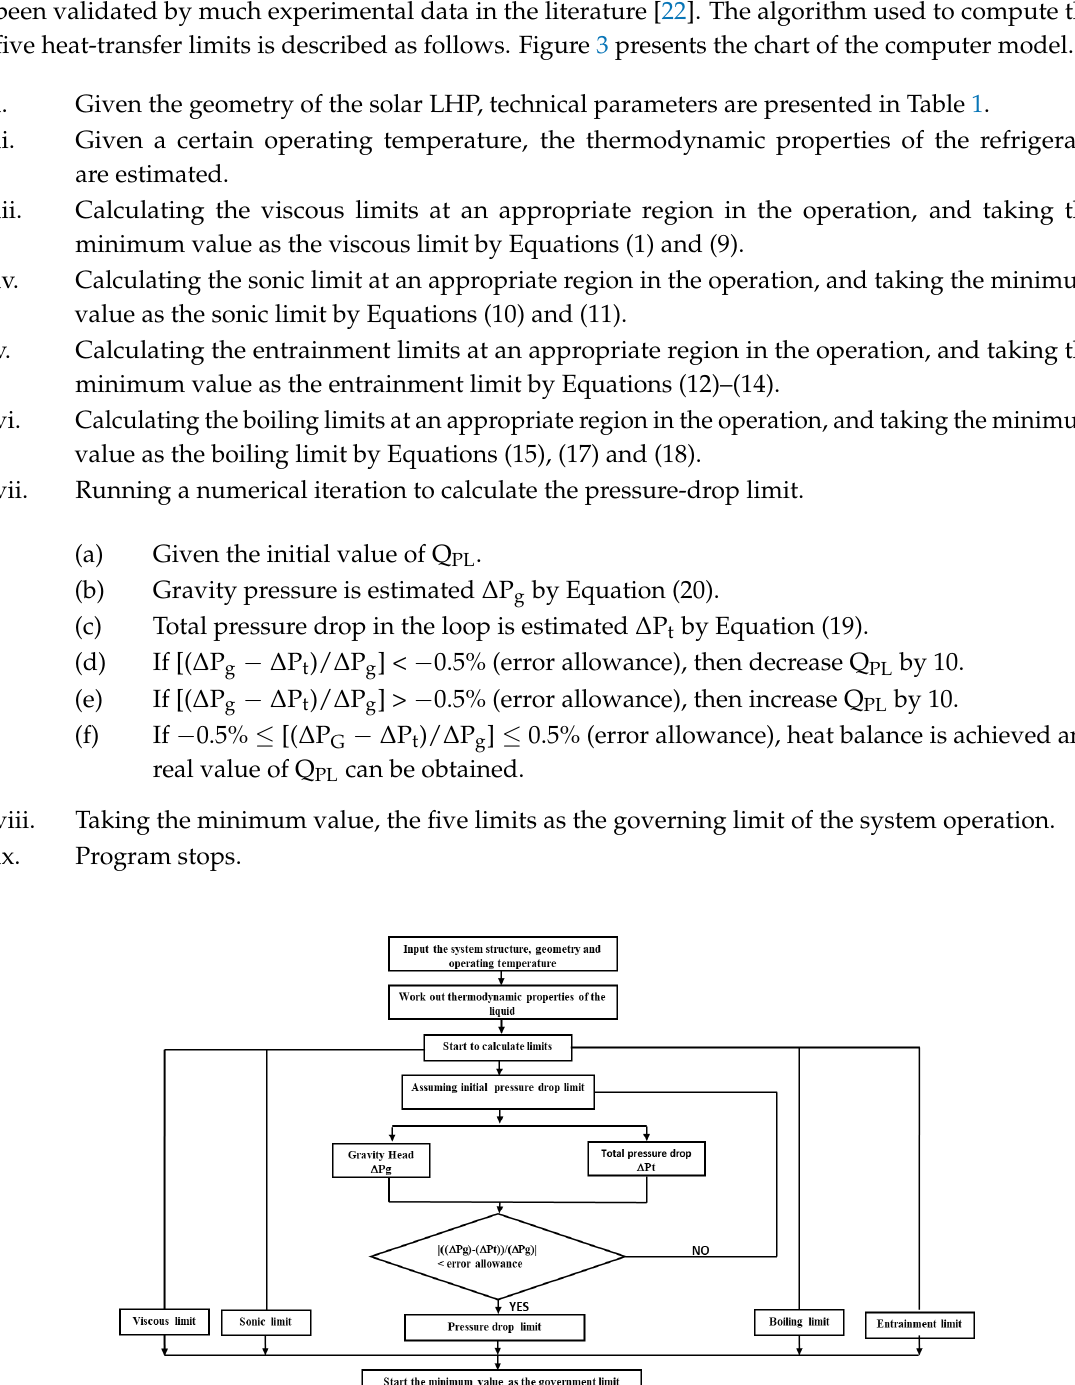
Table 2. Impact of the operating temperature.